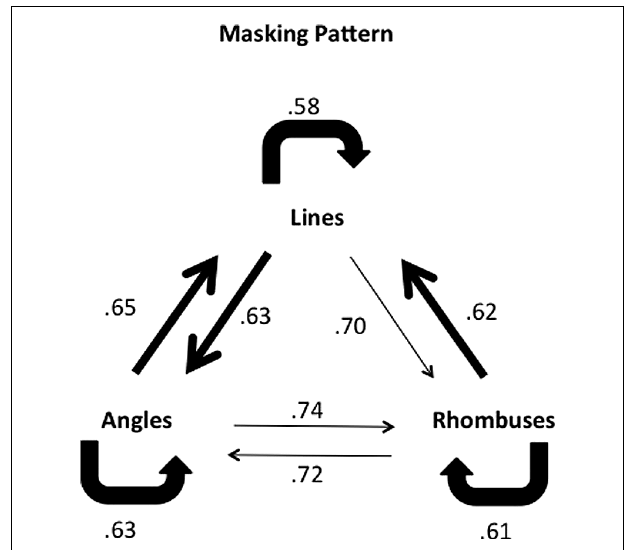
FIGURE 7 | Combined masking pattern of the three experiments for the 17 ms ISI setting. The pattern of differential masking for lines and angles suggests that they are processed in the same, possibly recurrent, system. Angles and rhombuses only weakly mask each other. Rhombuses mask lines strongly, but lines mask rhombuses to a lesser extent. Conventions as in previous